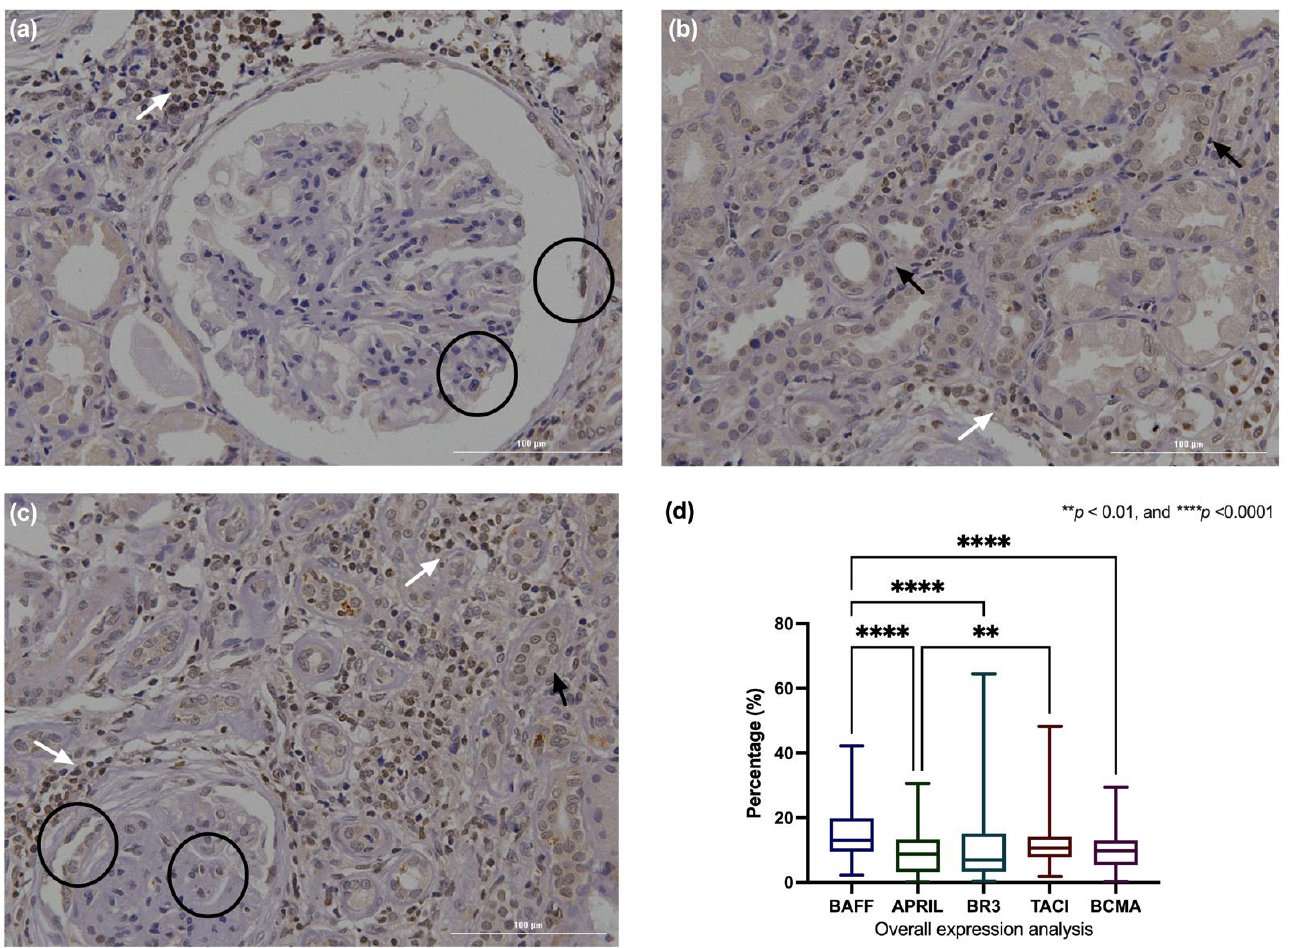
Figure 2. Overall analysis of BAFF system expression in LN. BAFF system expression according to glomerular, tubular, and interstitial zones is illustrated in ( a – c ). Black circles, black arrows, and white arrows indicate glomerular, tubular, and interstitial BAFF system expression, respectively. The overall expression analysis indicated a higher expression of BAFF and TACI than APRIL. Additionally, BAFF displays a higher expression of BR3 and BCMA ( d ). The p -value was obtained through Kruskal–Wallis and post hoc tests. Data are shown as the median with IQR. BAFF: B-cells activating factor, APRIL: A proliferation-inducing ligand, BR3: BAFF receptor, TACI: Transmembrane activator and CALM interactor, BCMA: B-cell maturation antigen, IQR: Interquartile